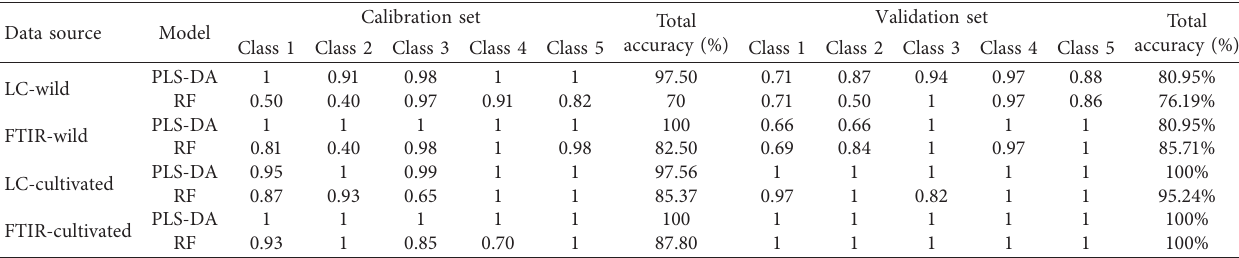
Table 1: The classification efficiency and total accuracy rate of independent decision making.